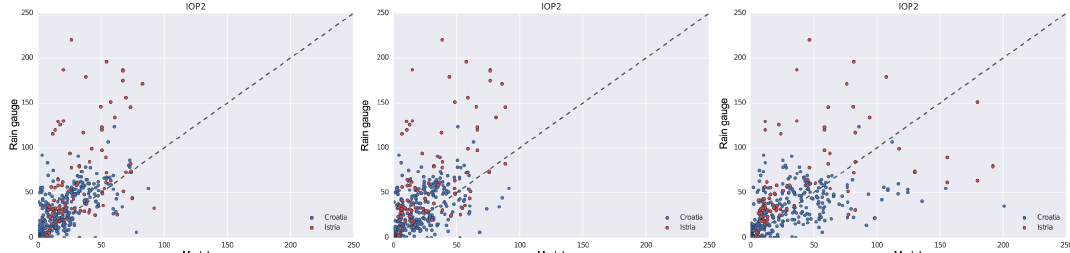
Figure 16. Scatter plot of 24h accumulated precipitation from rain gauges over Croatia and the model equivalents from the ALADIN 8km (left), ALADIN 8km without data assimilation (middle), and ALADIN 2km (right) models and from the point nearest the location of the rain gauge for IOP2. The locations from the Istria peninsula are marked in